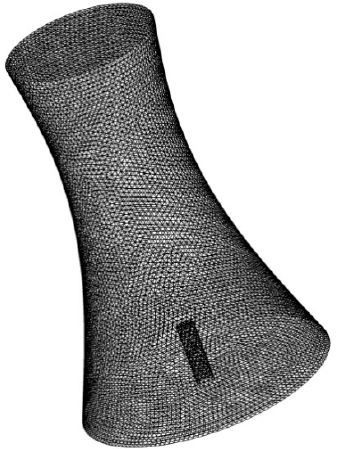
Figure 8. Finite element model of the cooling tower with a flue gas tube.